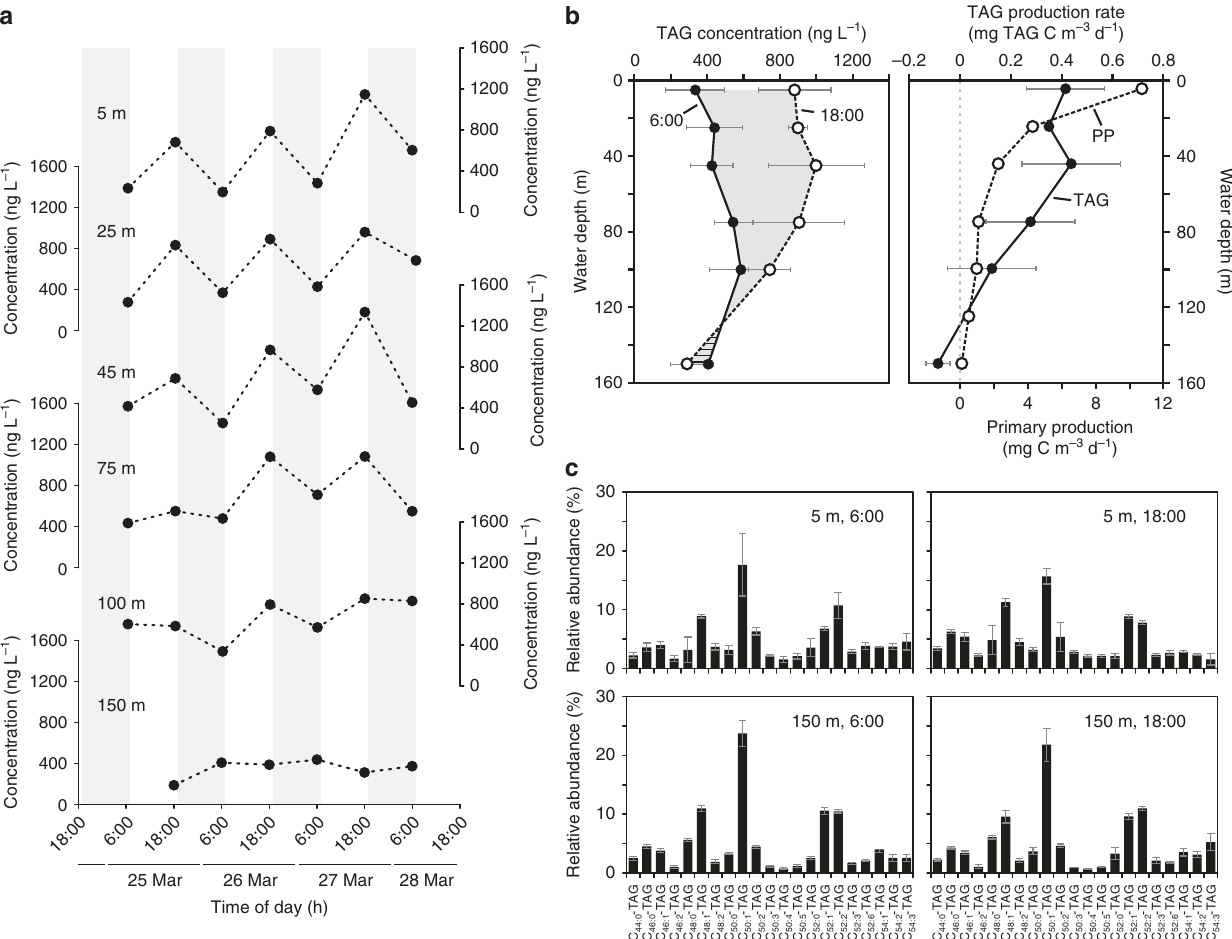
Fig. 2 Diel patterns in triacylglycerols at different water depths. a Concentrations of triacylglycerols (TAGs) for dusk (~06:00 h, local time) and dawn (~18:00h) over 4 day/night cycles (gray areas in indicate night) in March 2016 at different water depths at Station ALOHA. b Time-of-day average of depth pro fi les of TAGs and derived production rates (mg TAG C m − 3 d − 1 ) as well as primary production (PP, mg C m − 3 d − 1 ). c TAG composition averaged for time of day at 5 and 150 m water depth. Bars in b and c are the mean ± SD ( n ≥